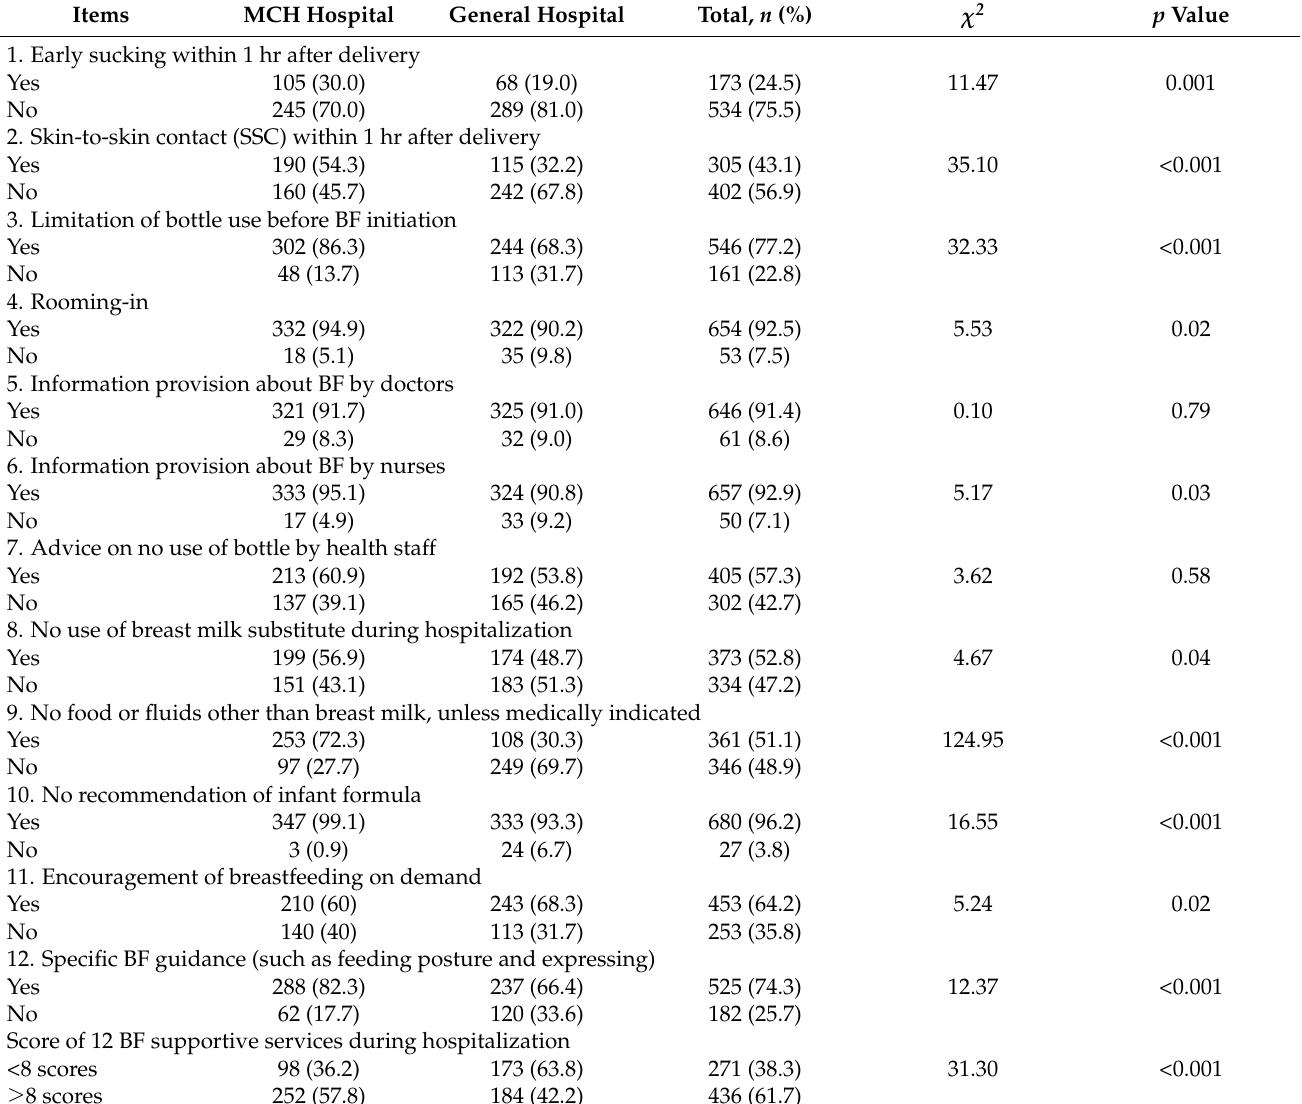
Table 2 presented the status of postnatal BF supportive services provided by BFHs. Only 24.5% of mothers had early initiation of BF and 43.1% of mothers had skin-to-skin contact (SSC) within one hour after birth. Among the 12 BF in-hospital supportive service items, four services achieved high coverage, including rooming-in, providing BF informa- tion by doctors, providing BF information by nurses, and no recommendation of infant formula. The chi-square ( χ 2 ) test showed a significant difference between MCH hospitals and general hospitals on BF supportive services. MCH hospitals consistently performed better in early initiation and SSC within one hour after birth, no bottle use before BF initia- tion, rooming-in practice, information provision on BF, restriction on the use of breast milk substitute during hospitalization, encouragement of BF on demand, no recommendation of infant formula, BF guidance and human milk as the primary food after birth ( p < 0.05). Table 2. The twelve breastfeeding (BF) supportive services provided by Maternal and Child Health (MCH) Hospitals and general